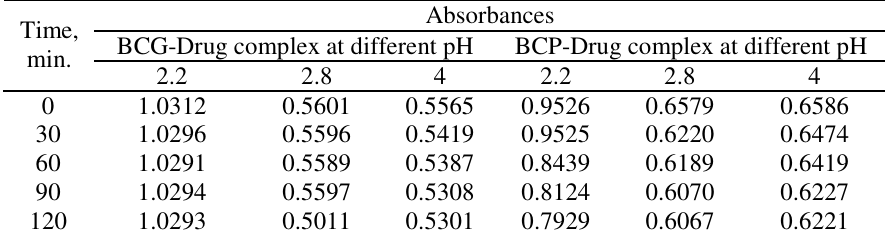
Table 1. Optimization of